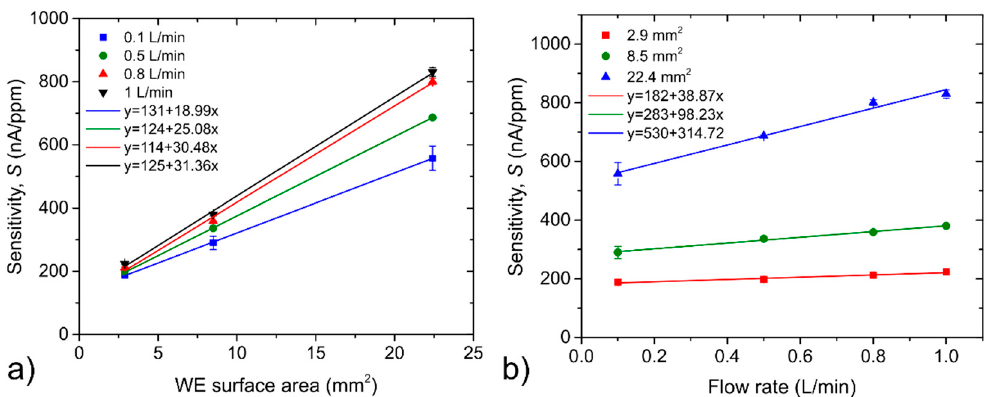
Figure 5. ( a ) Sensitivity dependence on the WE surface area; ( b ) sensitivity dependence on the analyte flow rate. The error bars in Figure 5 represent the standard error of the slope of the calibration curve (sensitivity) that was constructed by linear regression.